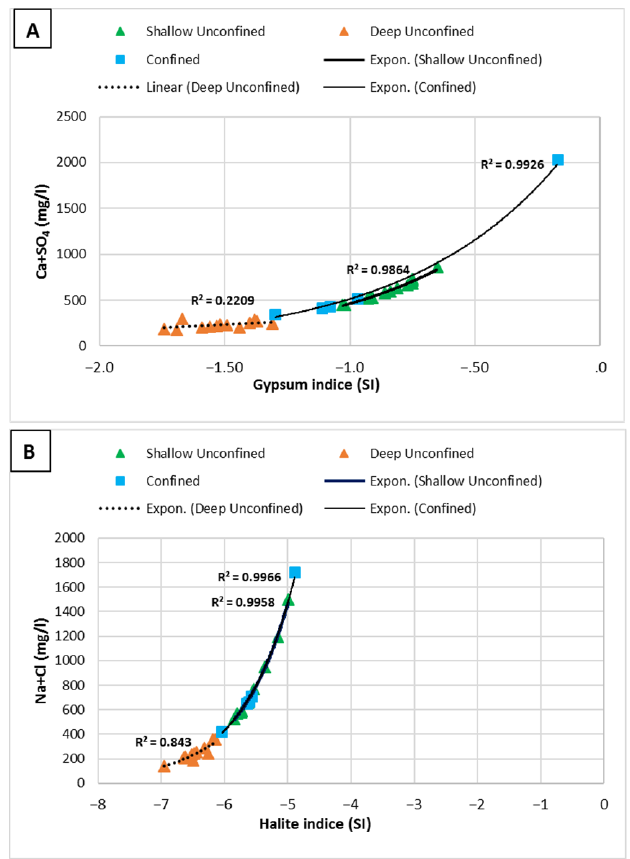
Figure 11. Scatter plots showing the relationship between ( A ) gypsum SI and Ca + SO 4 and ( B ) halite SI and Na +